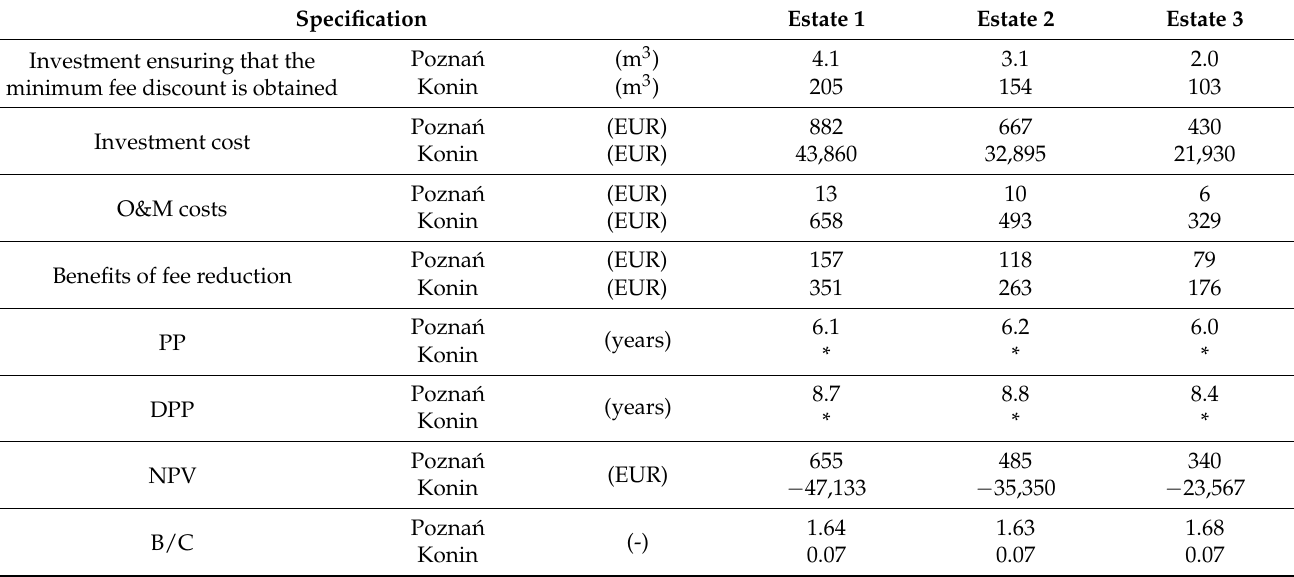
Table 13. Evaluation of the profitability of using minimalist investment strategies that provide municipal rainwater fee